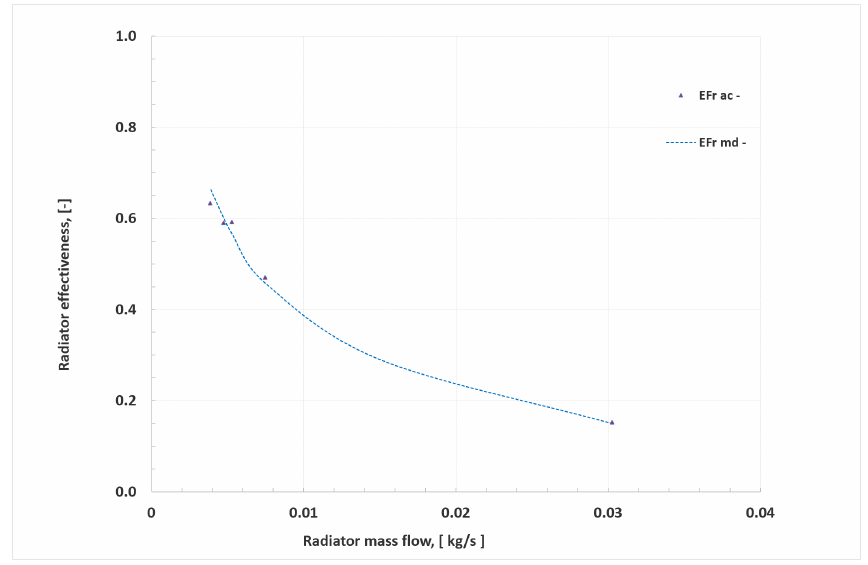
Figure 33. Convector Radiator -8 RR —effectiveness according to the tests and simulations calculations by “ NEHTMiR md ” in the mass flow range m r from 23% to 150% of the nominal value. Example 10. q mx = 0.0303 kg/s, t s = 51.2 ◦ C, t i = 21.0 ◦ C, ∆ t 1 = 51.2 − 21.0 = 30.2